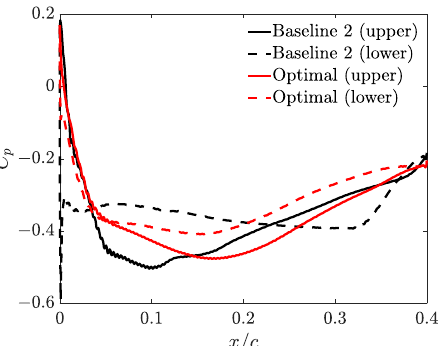
Figure 16. The pressure coefficients of Baseline model 2 and optimal model at the symmetry plane. The solid and dashed lines present the pressure coefficient on the upper and lower surfaces, respec-